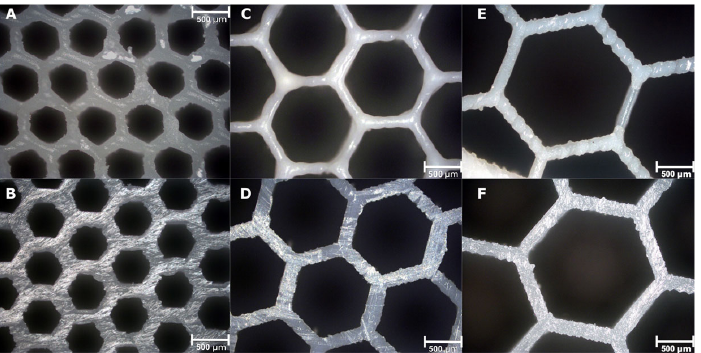
Figure 6. SEM images of 10% drug loading immediate release tablet with channel diameter of ( A , B ) 0.6 mm, ( C , D ) 1.22 mm and ( E , F ) 1.83 mm. ( A , C , E ) Top surface. ( B , D , F ) Bottom